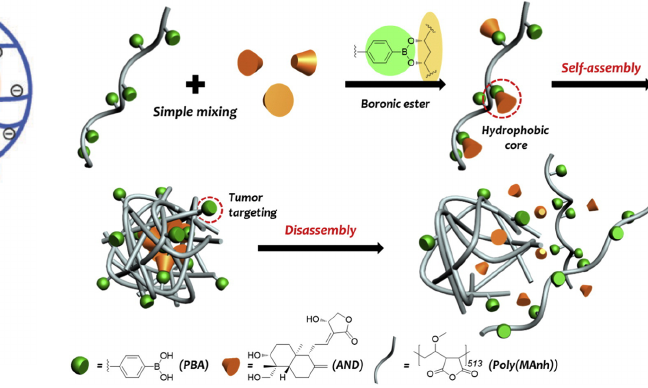
Figure 19: Reversible fluorescence quenching and anti-quenching of CdS QDs-immobilized p(NIPAM-AAm-PBA) microgels in response to different glucose concentrations. Reproduced with permission from [71]. Copyright 2009, The Royal Society of Chemistry